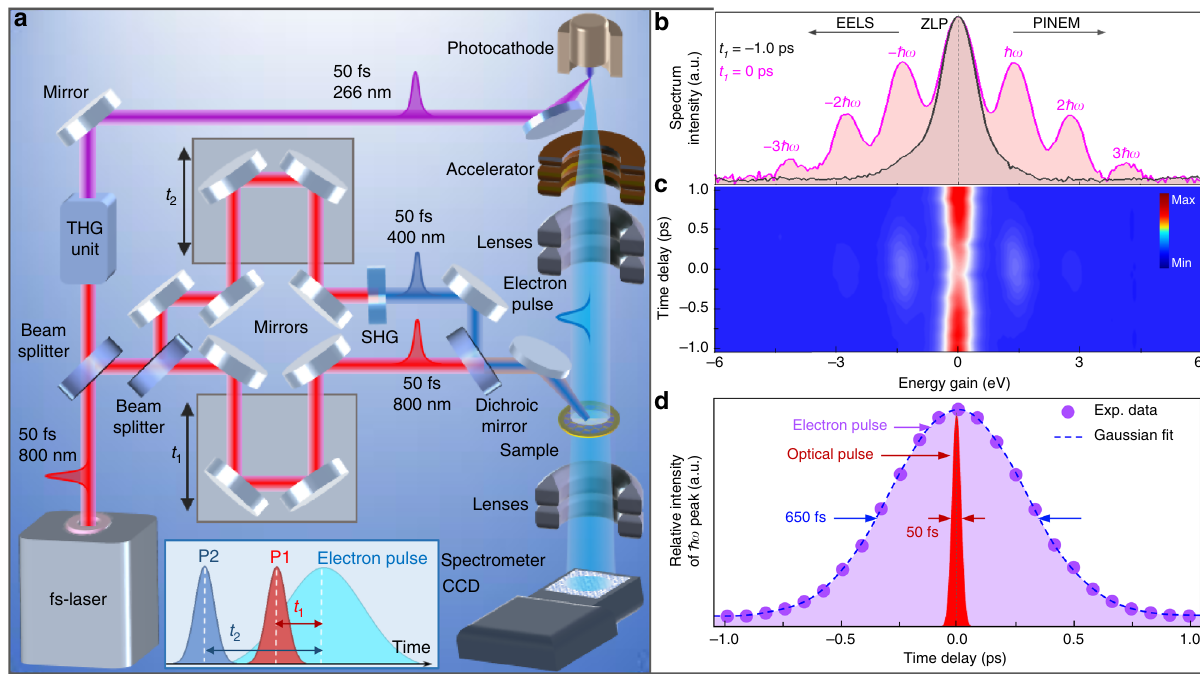
Fig. 1 Two-color near- fi eld electron microscopy. a Experimental set-up for two-color near- fi eld electron microscopy. NIR 50-fs optical pulses (800 nm) are separated into two parts by a beam-splitter. One portion is frequency-tripled to generate UV pulses (266 nm) via a third harmonic generator (THG) unit, which are then directed to the photocathode to generate ultrafast electron pulses. The other portion of the NIR laser is further split into two parts: one is left unchanged (800 nm, P1), while the other is frequency doubled by a second harmonic generator (SHG) to generate visible optical pulses (400 nm, P2). The time delays t 1 and t 2 between the two optical pulses and electron pulse are controlled by two linear delay stages. The visible and NIR pulses are recombined via a dichroic mirror and focused onto the specimen in the microscope. The bottom inset shows the time axis of the visible (P1) and NIR pulses (P2) and their delays ( t 1 , t 2 ) relative to the electron pulse at the specimen plane. b , d One-color PINEM results of a single VO 2 NW (diameter of ~350 nm) using the P1 optical pulse ( fl uence of ~4.1 mJ/cm 2 ) with the fi eld polarization perpendicular to the NW axis. b Two representative PINEM spectra at t 1 = − 1.0 ps (gray curve) and 0 ps (pink curve), respectively, in which each spectrum is normalized by its own maximum intensity. c PINEM spectrogram of photon – electron coupling between the P1 pulse and the electron pulse as a function of the P1 delay time ( t 1 ). d Cross-correlation temporal pro fi le (violet dots and fi tted blue curve) obtained by integrating the PINEM peaks at each instant of the P1 pulse arrival time ( t 1 ); the plot shows the temporal pro fi le of the electron pulse (~650fs). The shaded red curve represents, instead, the time window of the optical gating, which corresponds to the temporal duration of the optical pulse P1 (50